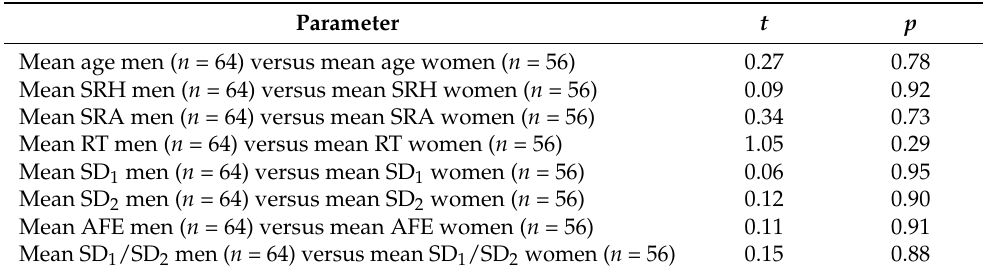
Table 3. The t -test values, the thresholds of statistical significance p for differences between men and women subgroups’ means.